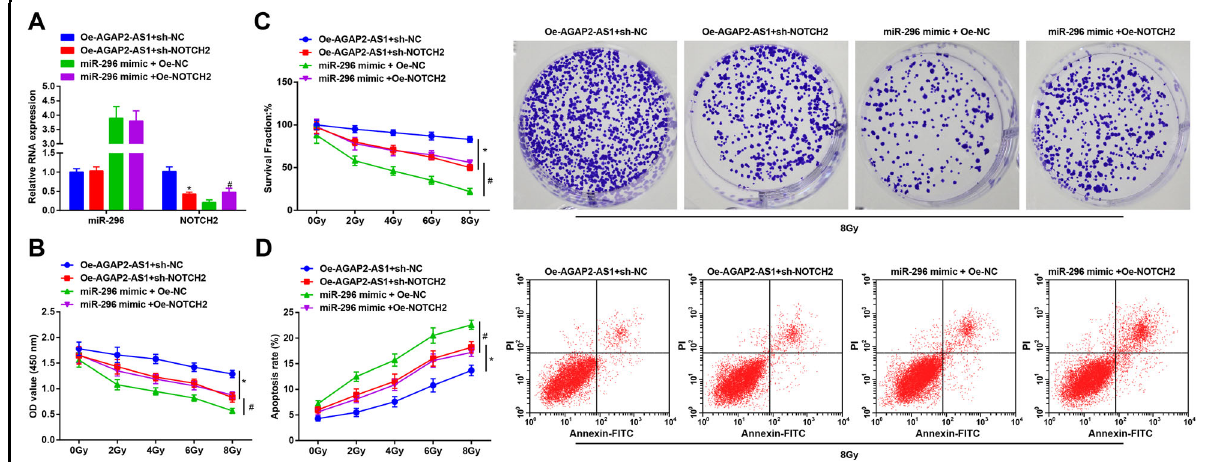
Fig. 7 NOTCH2 overexpression rescues the effects of miR-296 upregulation on radioresistance of radioresistant lung cancer cells. A Detection of transfection ef fi ciency of A549R26-1 cells. B Proliferation of A549R26-1 cells was detected by CCK-8 assay. C Survival rate of A549R26-1 cells was detected by colony formation assay. D Apoptosis rate of A549R26-1 cells was detected by fl ow cytometry. N = 3; * P < 0.05 vs. the Oe-AGAP2 + sh-NC group, # P < 0.05 vs. the miR-296 mimic + Oe-NC group; the measurement data were expressed as mean ± standard deviation, one-way ANOVA was usedfor comparisons among multiple groups and Tukey ’ s post hoc test was used for pairwise comparisons after one-way